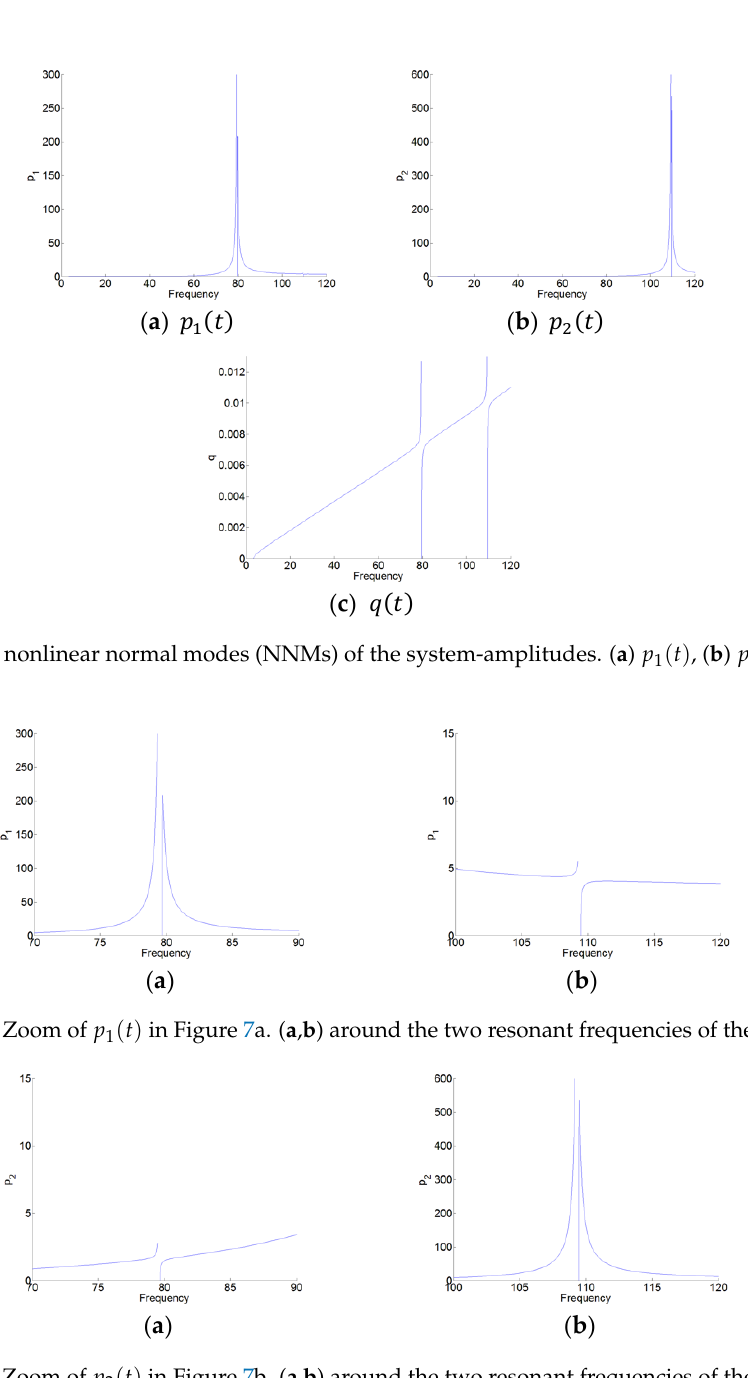
Figure 9. Zoom of 𝑝 2 (𝑡) in Figure 7b. ( a , b ) around the two resonant frequencies of the cavity.